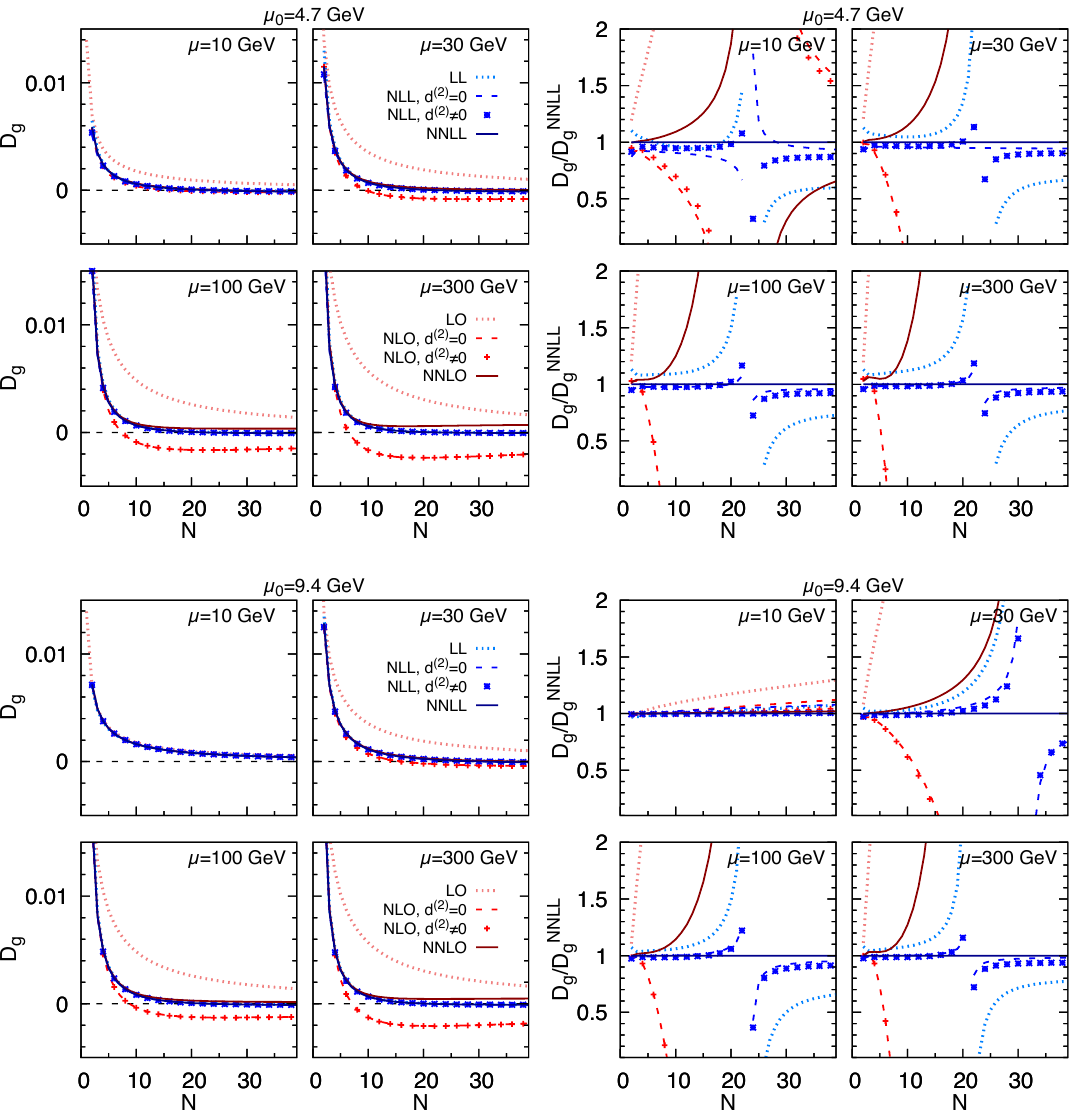
Figure 2 . Same as (cid:12)gure 1, for the gluon fragmentation